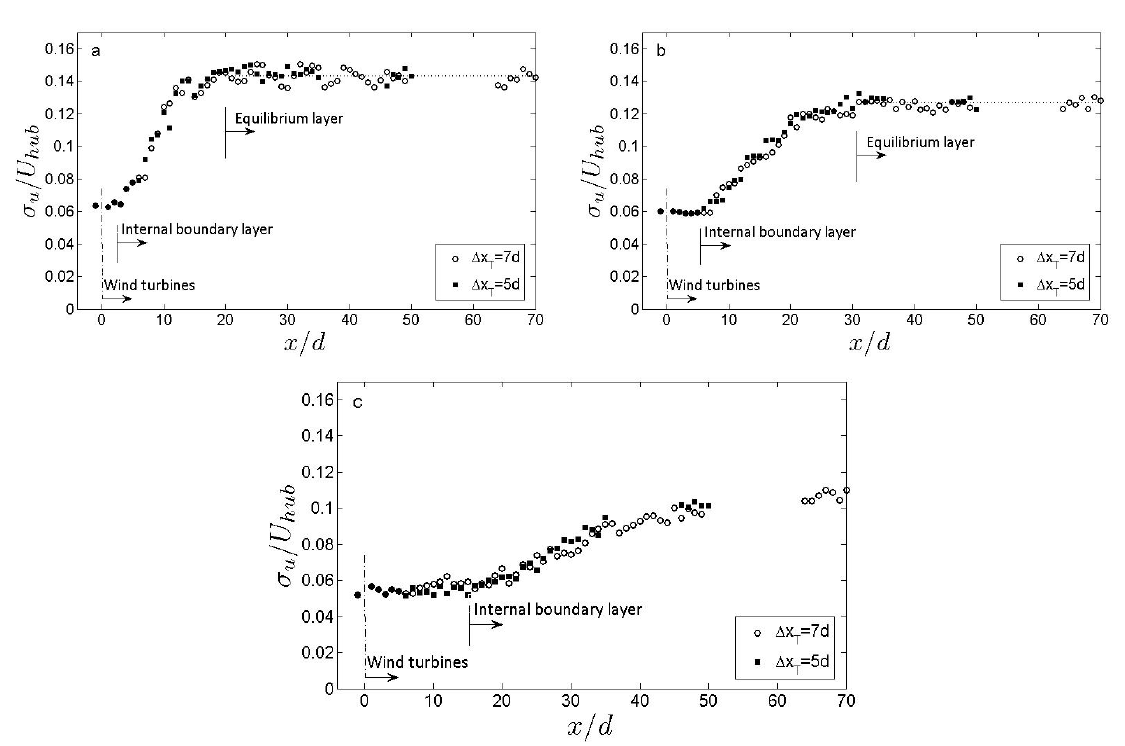
Figure 8. Turbulence intensity distribution at different heights above the wind farm.